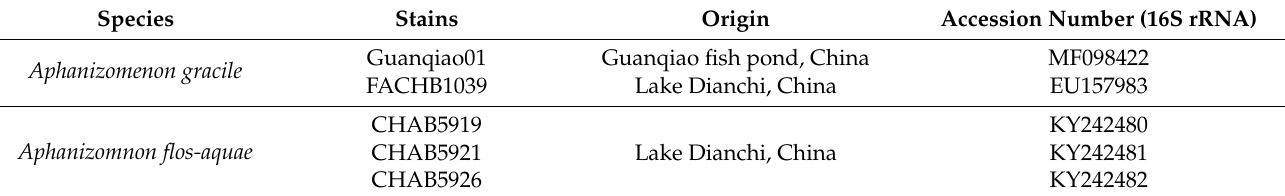
Table 1. The GenBank accession numbers of Aphanizomenon strains in this